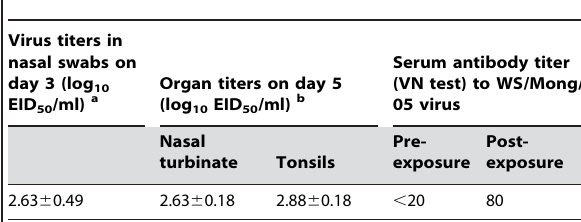
a Virus was detected in nasal swabs from 2 of 4 pigs on day 3 only. b Virus was detected only in nasal turbinate and tonsils of 2 pigs killed on day 5 after consumption of infected chicken meat.